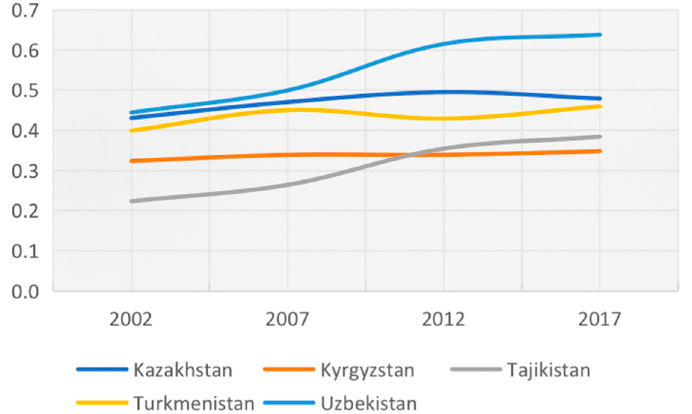
Figure 2. Change of composite scores of agricultural sustainability level in Central Asia.